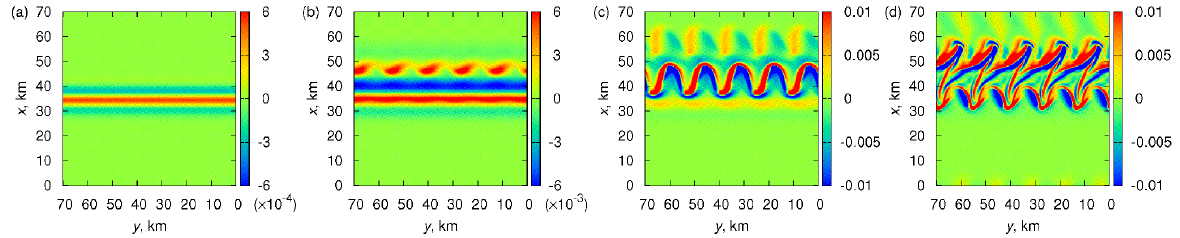
Figure 2. Vorticity ω at the ionosphere s = 0 at the time of (a) t/τ A = 0 . 1, (b) 4, (c) 5.8, and (d) 7 in the case of a convection electric field E 0 = 60mVm − 1 . Note that the y axis is reversed ( x × y (cid:107) b 0 ) because we are considering the Southern Hemisphere.